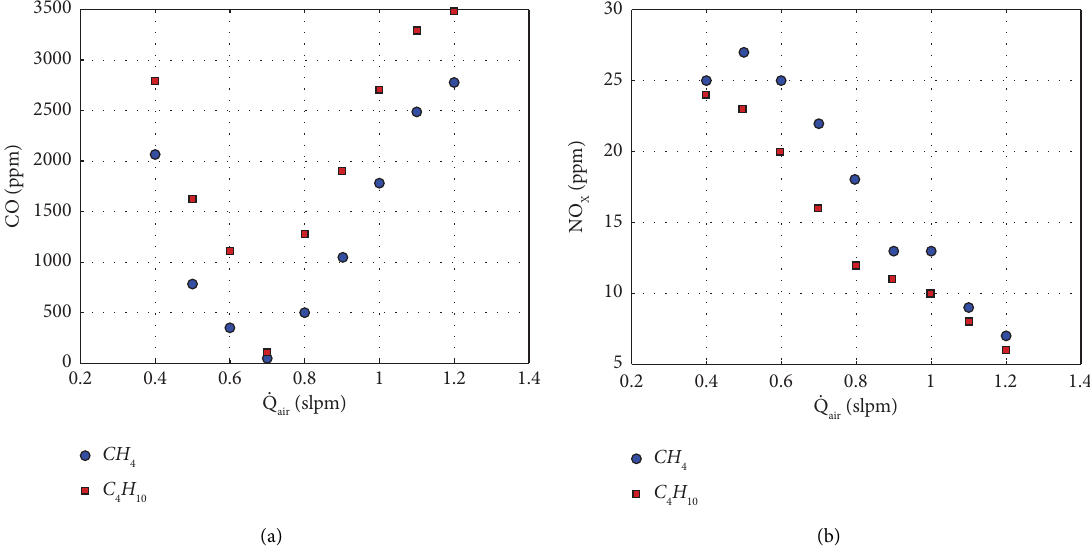
Figure 16: Variation of (a) CO and (b) NO